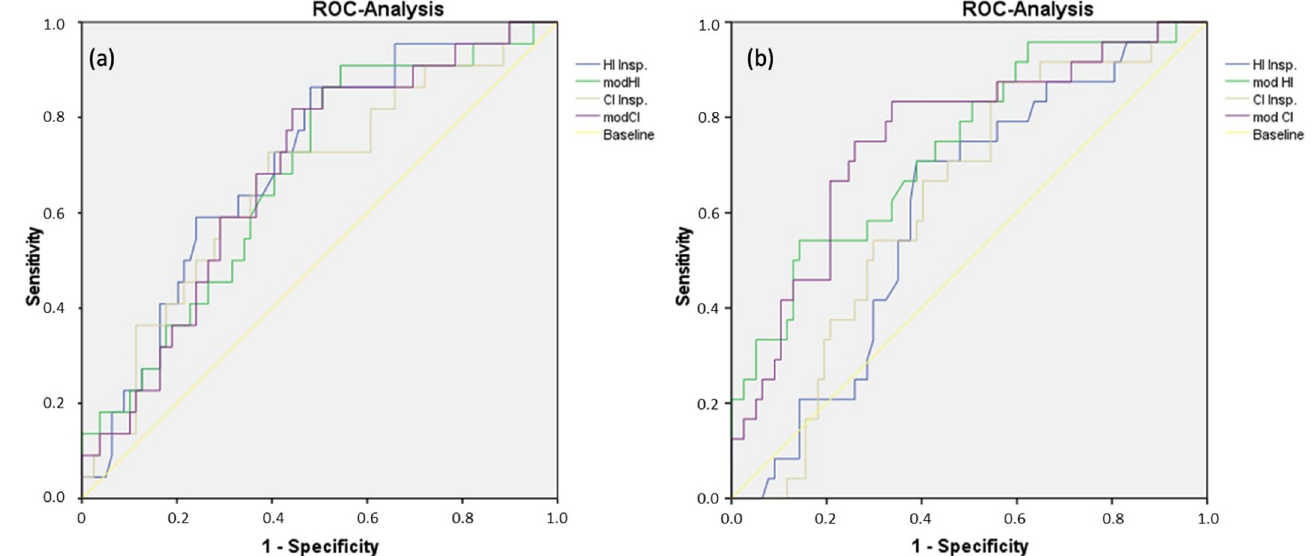
Figure 4. ROC analyses of reduced VO 2max % and reduced O 2 -pulsemax%. ( a ) shows ROC curves of sensitivity and 1-specificity of HI insp (AUC 0.703), modHI (AUC 0.677), CI insp (AUC 0.667), and modCI (AUC 0.681), related to a VO 2max % less than 85% as the state variable. ( b ) shows ROC curves of sensitivity and 1-specificity of HI insp (AUC 0.067), modHI (AUC 0.738), CI insp (AUC 0.627), and modCI (AUC 0.757), related to an O 2 -pulse max % less than 80% as the state variable.